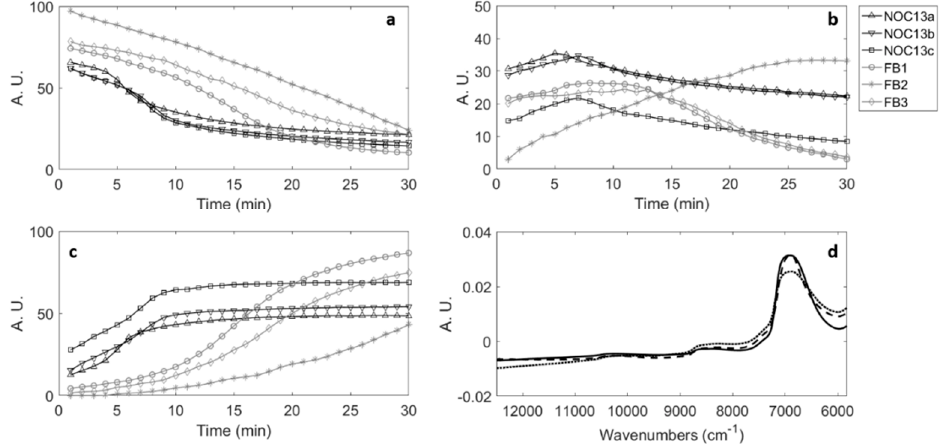
Figure 5. MCR-ALS results for the three replicates of NOC 13 (normal operating conditions) batch and for the three failure batches (FB): ( a ) concentration profiles of the liquid-like behavior of milk; ( b ) concentration profiles of the transition phase of renneting; ( c ) concentration profiles of the solid-like behavior of coagulated milk; ( d ) spectral profiles of liquid-like behavior of milk (solid line), transition phase (dashed line) and solid-like behavior of milk (dotted